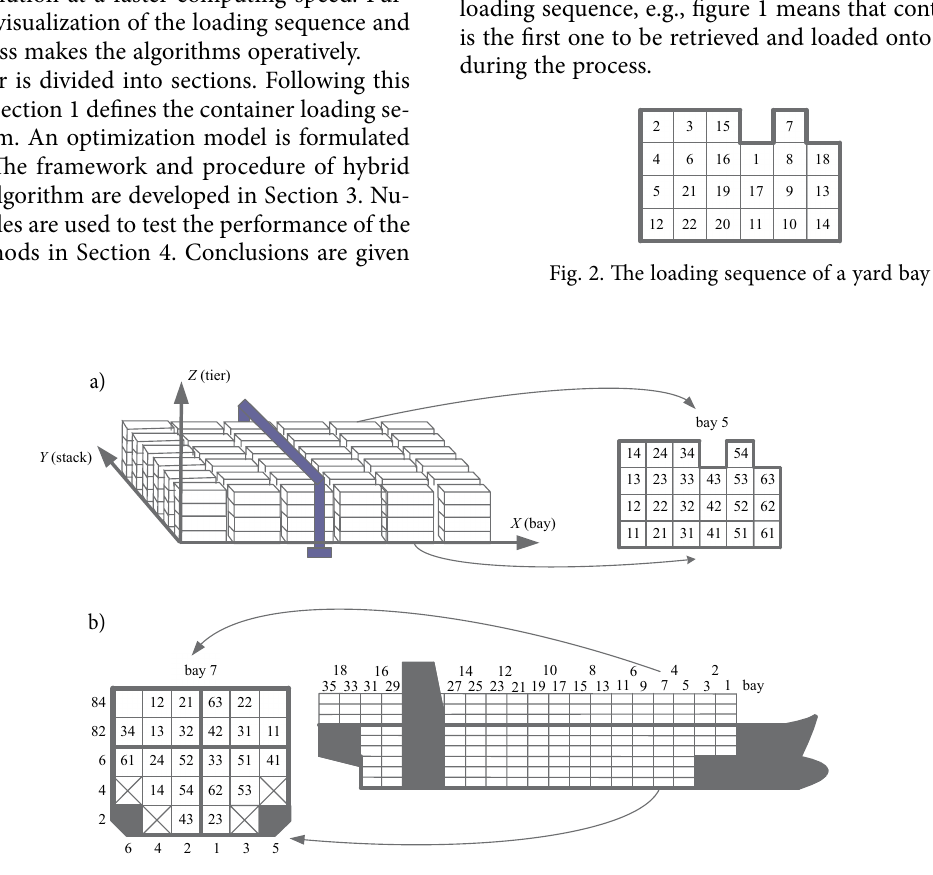
Fig. 1. Illustrations of the yard plan and stowage plan of a bay: a – the yard plan of bay 5; b – the stowage plan of yard bay